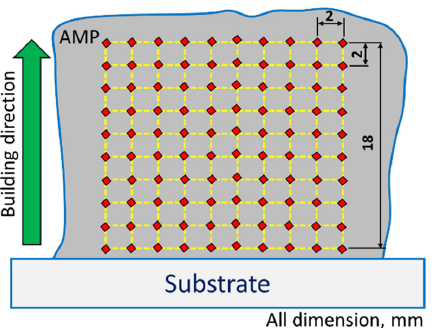
Figure 4 . A schematic drawing illustrates the location of hardness mapping measurements. Figure 4. A schematic drawing illustrates the location of hardness mapping